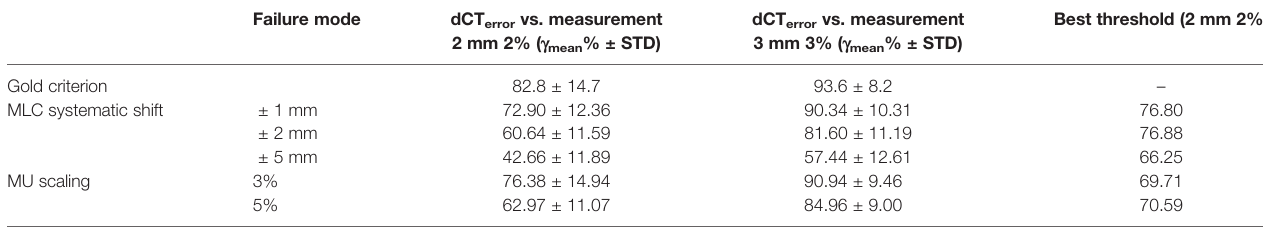
TABLE 2 | Mean and standard deviation of gamma passing rate for different error introduction and best threshold in varying